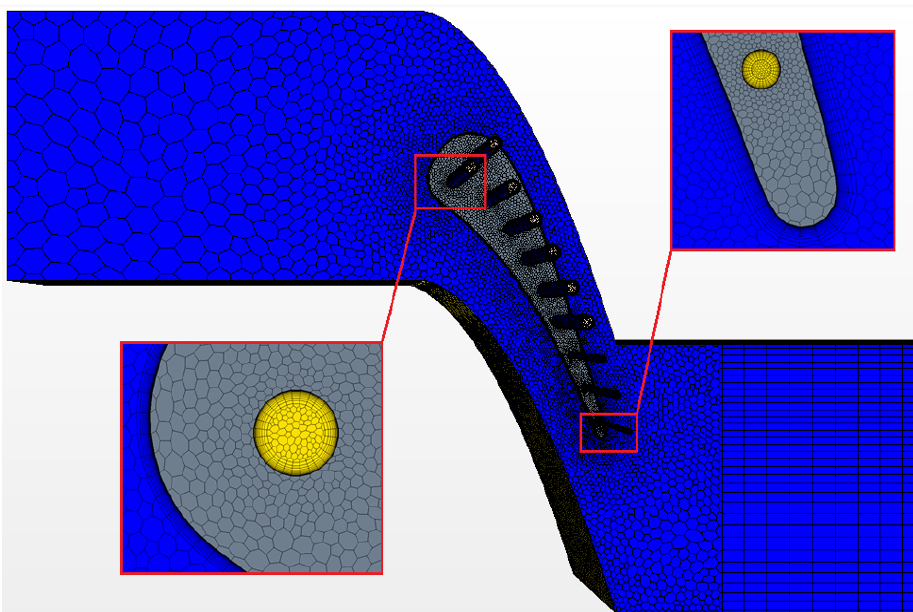
Figure 3. Schematic of the generated mesh in the X-Y plane, with detailed representation of the leading and trailing edge of the vane.